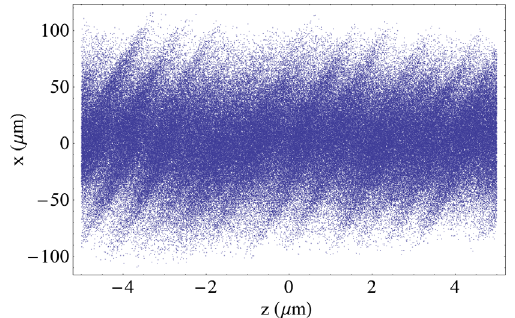
FIG. 6. The beam current profile as seen at the entrance of DL1 (black curve) shows ∼ 1% longitudinal bunching amplitude at about λ ≃ 1 μ m wavelength. By the exit of the dogleg (red curve) bunching has grown to about 4%, implying a net ∼ 3% con- tribution from TSC in the dogleg. The quoted numbers are about the middle of the observed value